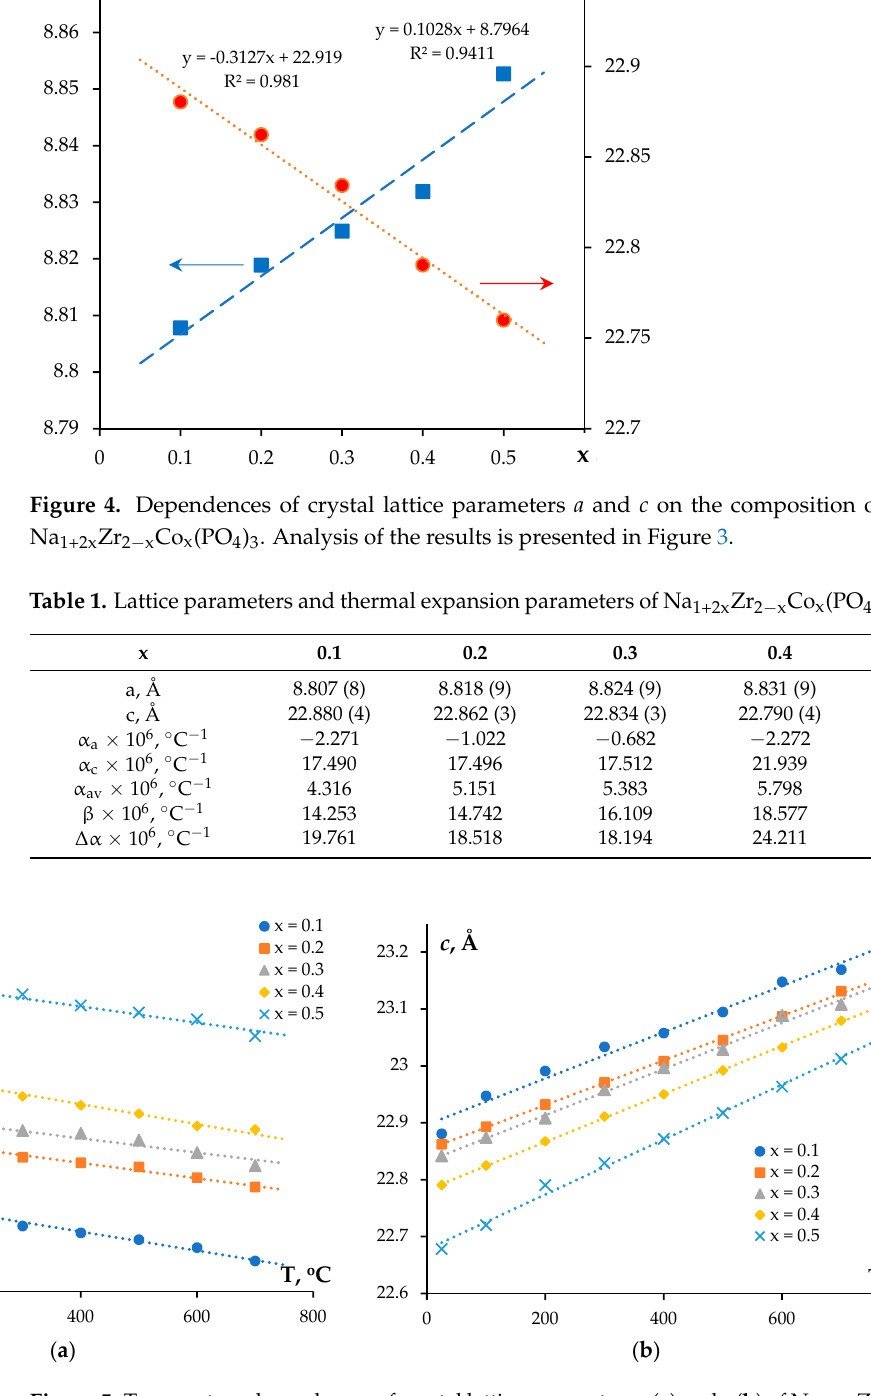
Figure 5. Temperature dependences of crystal lattice parameters a ( a ) and c ( b ) of Na 1+2x Zr 2-x Co x (PO 4 ) 3 compounds. Table 1. Lattice parameters and thermal expansion parameters of Na 1+2x Zr 2-x Co x (PO 4 ) 3 phosphates.